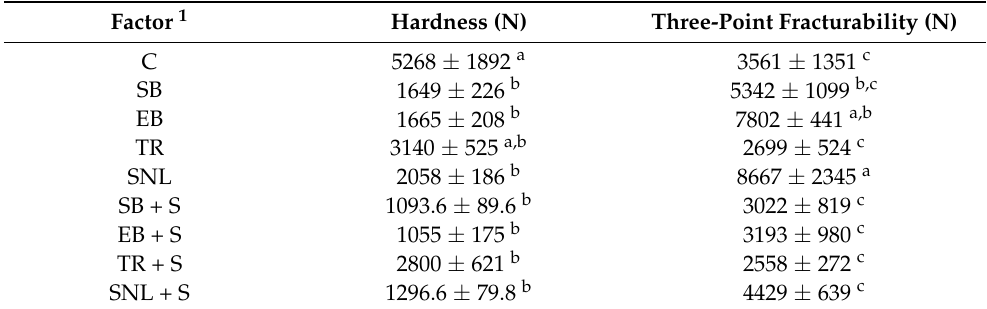
Table 6. Means and standard deviations for hardness and three-point fracturability of each treatment.